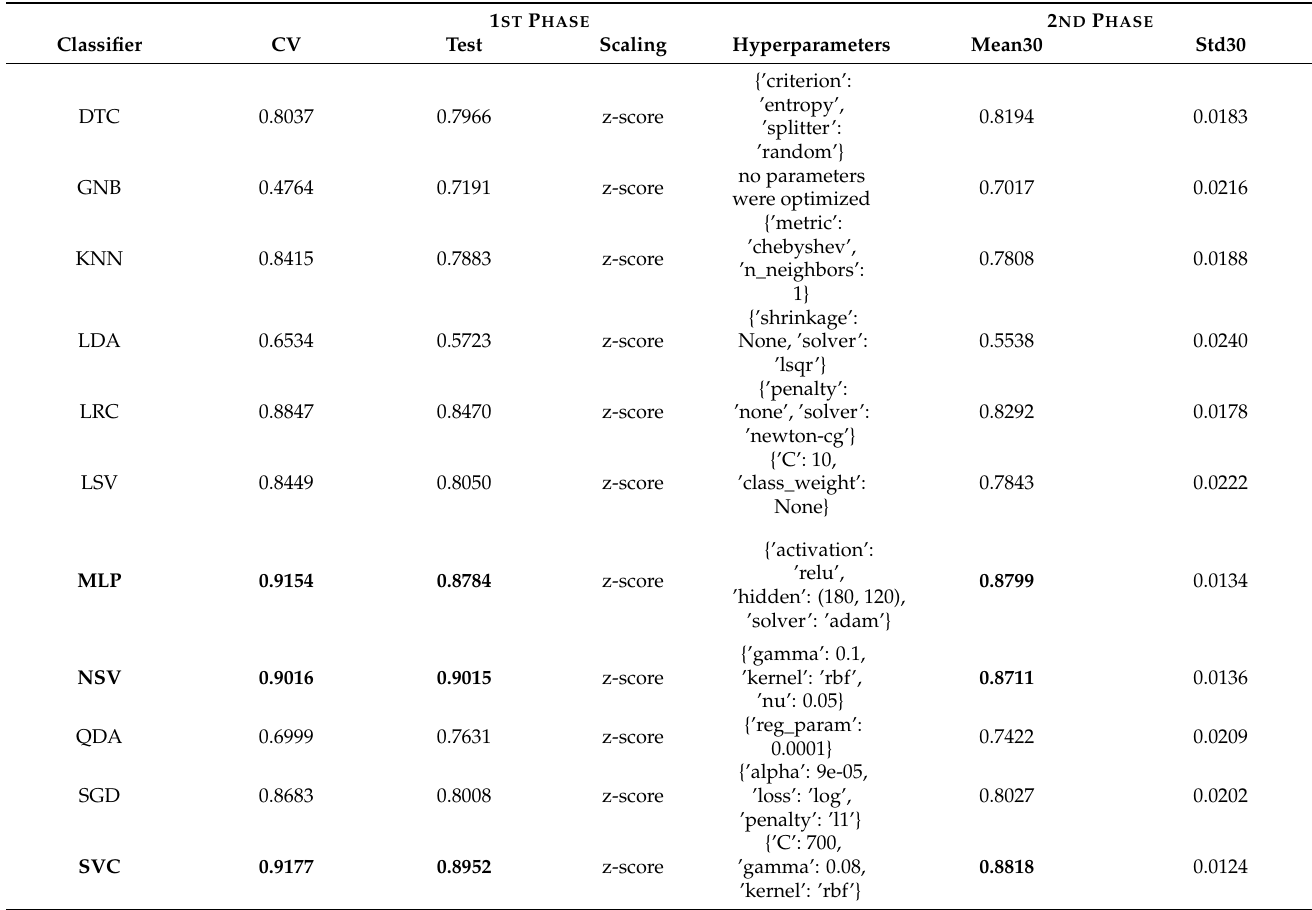
Table 5. Accuracy of the optimized basic classifiers (1st phase) and the results of their validation (2nd phase). The best results, where each value of CV , Test , Mean 30 > 0.85 are in bold. The scaling procedures are denoted as follows: z - score for standardization and norm for